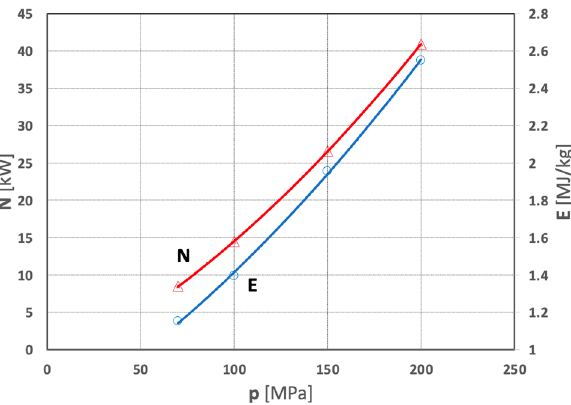
Figure 17. Influence of water jet pressure on water jet power (N) and unit energy expenditure (E) of water jet comminution of concretions (for d w = 0.7 mm, d h = 2.4 mm, s = 10 mm).